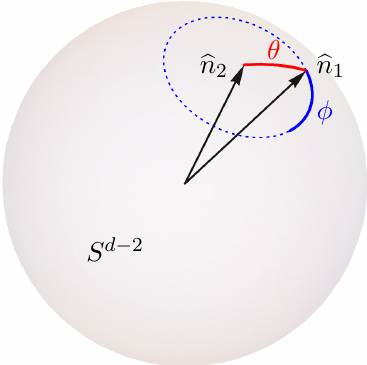
Figure 1 . The celestial sphere S d − 2 in a two-point event shape. The positions of the detectors are parametrized by n 1 , n 2 ∈ S d − 2 . The light-ray OPE is an expansion in the angle θ between detectors b b (solid red arc). Transverse spin j is conjugate to the angle φ of one detector around the other on the celestial sphere (solid blue